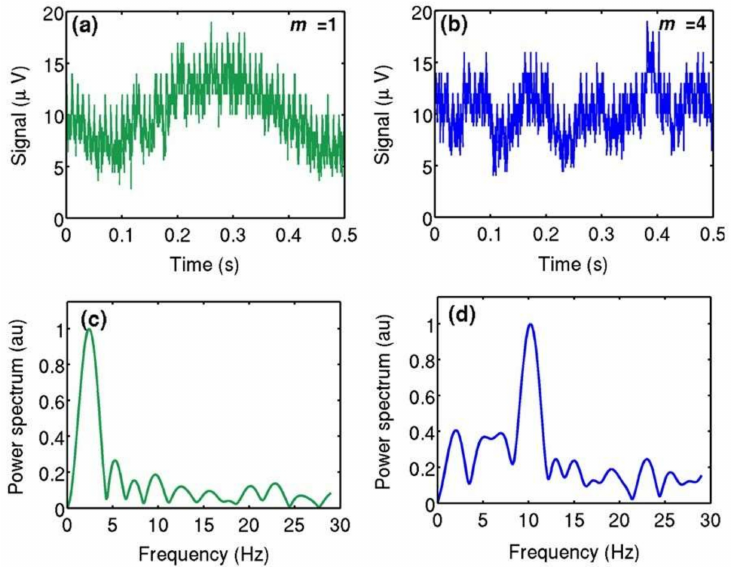
Figure 4. Output signals of PD under different topological loads ( a ) m = 1 and ( b ) m = 4, and the corresponding Fourier transform spectrum ( c , d ). Adapted with permission from ref.